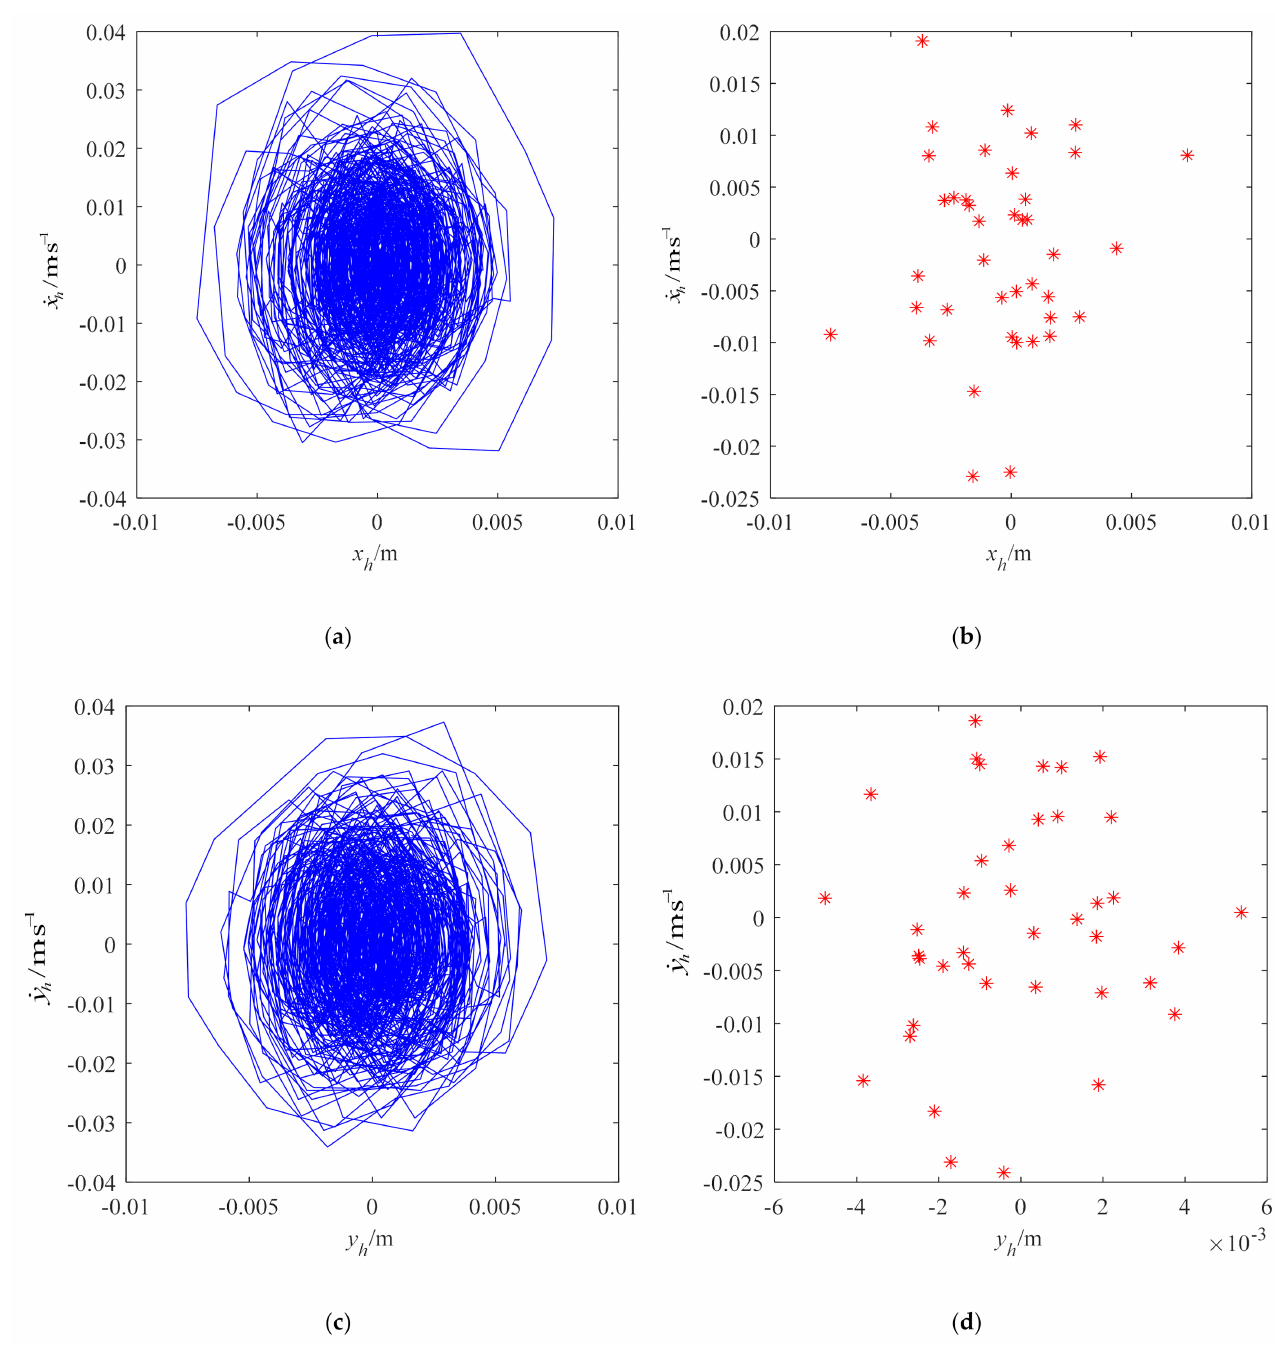
Figure 5. Vibration characteristics of the cutting head when f p = 6. ( a ) x h -direction vibration phase diagram of the cutting head, ( b ) x h -direction Poincar é section of the cutting head, ( c ) y h -direction vibration phase diagram of the cutting head, ( d ) y h -direction Poincar é section of the cutting head. Every “*” in ( b , d ) represents one cycle of vibration